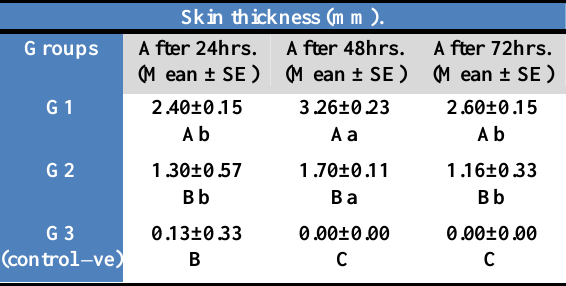
Table, 1: Skin thickness (mm) in immunized and control groups (Mean ±